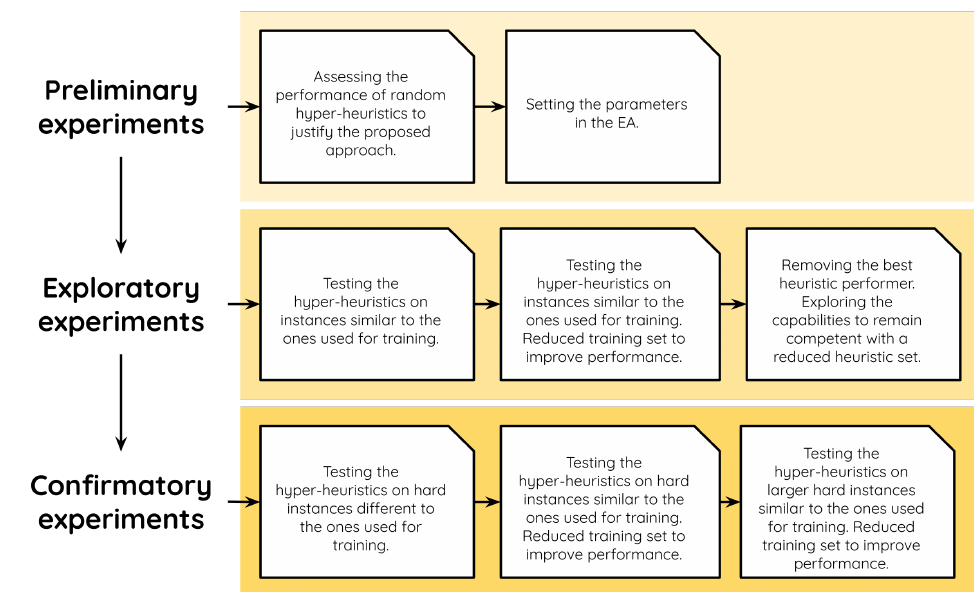
Figure 2. Three-stage methodology followed in this